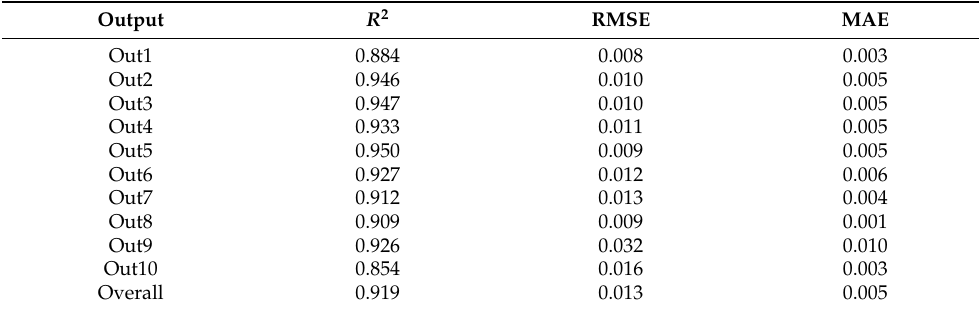
Figure 9. Scenario 3 (Out1 through Out10): plotting true vs. predicted values for both training and test samples. The available data are split into train/test sets according to Figure 1. We see that the surrogate model performs well on both training and test sets, and the R 2 values exceed 0.9 for all the studied outputs except for Out1 and Out10. Table 6. Evaluating the performance of the trained surrogate model using 10 outputs: Out1 through